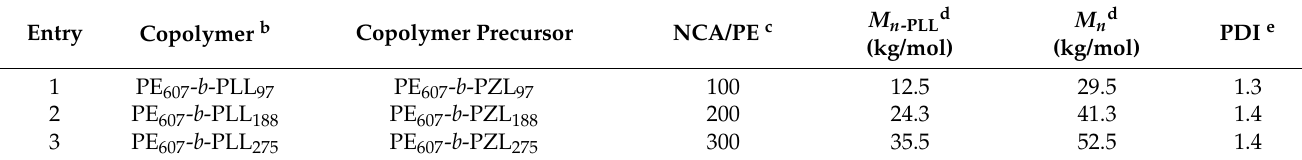
Table 1. Synthesis of and characterization of block copolymers. a